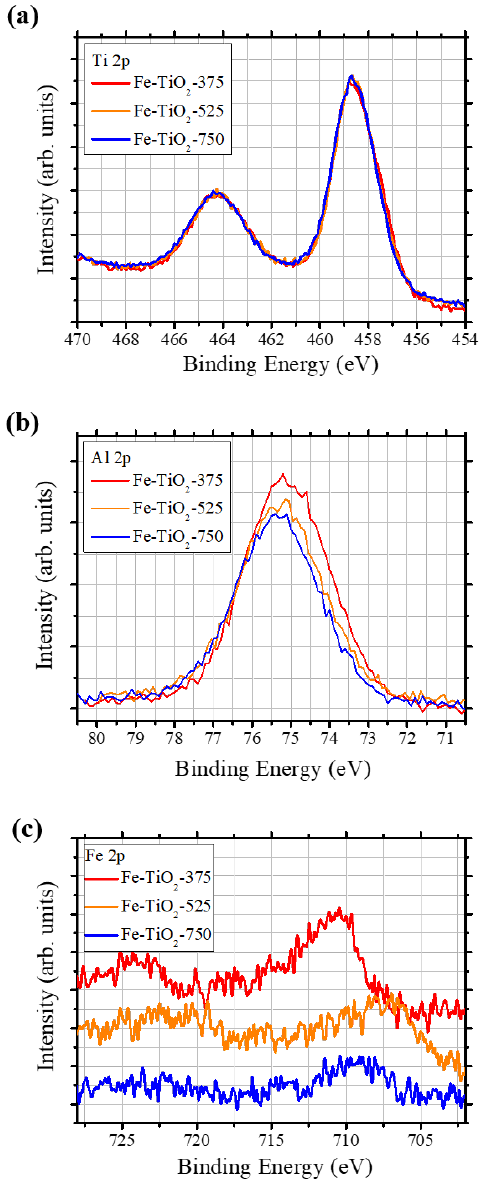
Figure 4. Results of XPS analysis. ( a ) Ti 2p, ( b ) Al 2p, and ( c ) Fe 2p core-level XPS spectra of Fe-TiO 2 -375, -525, and -750 samples.